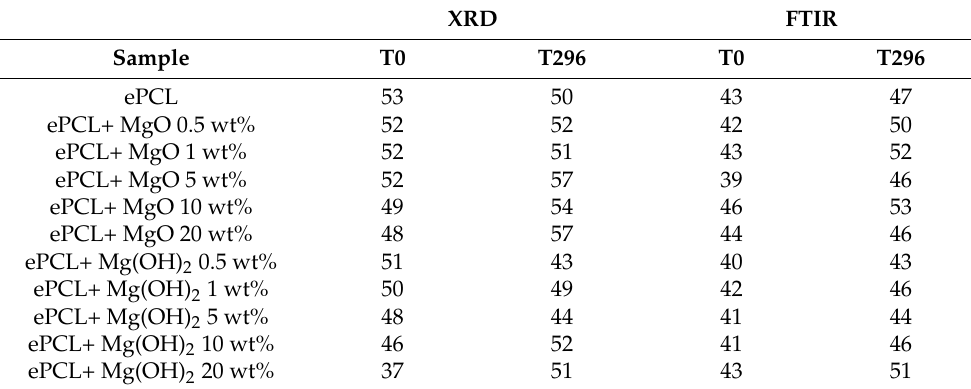
Table 1. CI% values calculated by XRD and FTIR at T0 and T296 for the different systems. XRD FTIR Sample T0 T296 T0 T296 ePCL 53 50 43 47 ePCL+ MgO 0.5 wt% 52 52 42 50 ePCL+ MgO 1 wt% 52 51 43 52 ePCL+ MgO 5 wt% 52 57 39 46 ePCL+ MgO 10 wt% 49 54 46 53 ePCL+ MgO 20 wt% 48 57 44 46 ePCL+ Mg(OH) 2 0.5 wt% 51 43 40 43 ePCL+ Mg(OH) 2 1 wt% 50 49 42 46 ePCL+ Mg(OH) 2 5 wt% 48 44 41 44 ePCL+ Mg(OH) 2 10 wt% 46 52 41 46 ePCL+ Mg(OH) 2 20 wt% 37 51 43